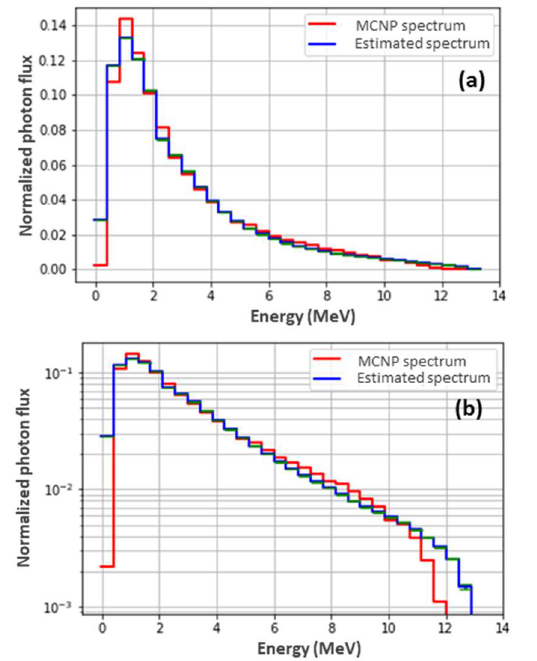
Fig. 5. Estimated average energy spectrum in linear (a) and logarithmic (b) scales with the green error bars representing the uncertainty of each channel. For each channel the uncertainty is represented by the green error bars in Fig. 5. The relative average uncertainty per channel with respect to the average spectrum is 1.3.10 -4 . This is defined by (5), where m is the number of channels in the energy of the spectra, (cid:1876) is the flux value of channel j for spectrum i , (cid:1876)̅ (cid:3037)(cid:3036) average flux of channel j for the n number of retained spectra, here n